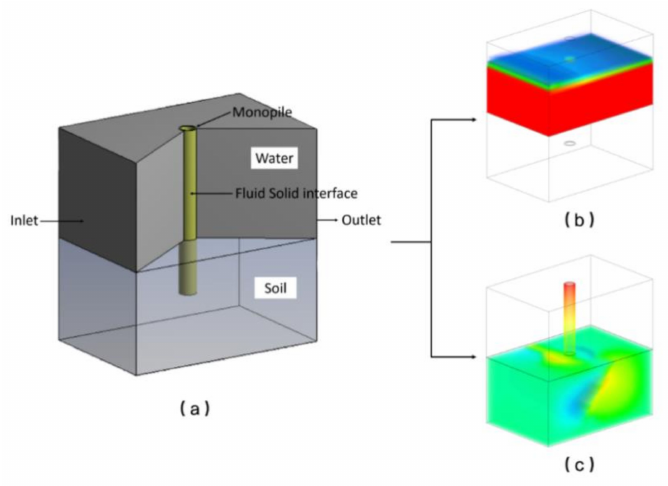
Figure3. 3DFEMmodel. ( a )wave-monopile-soilcouplingmodel;( b )wavemodel;( c )monopile-soilmodel.